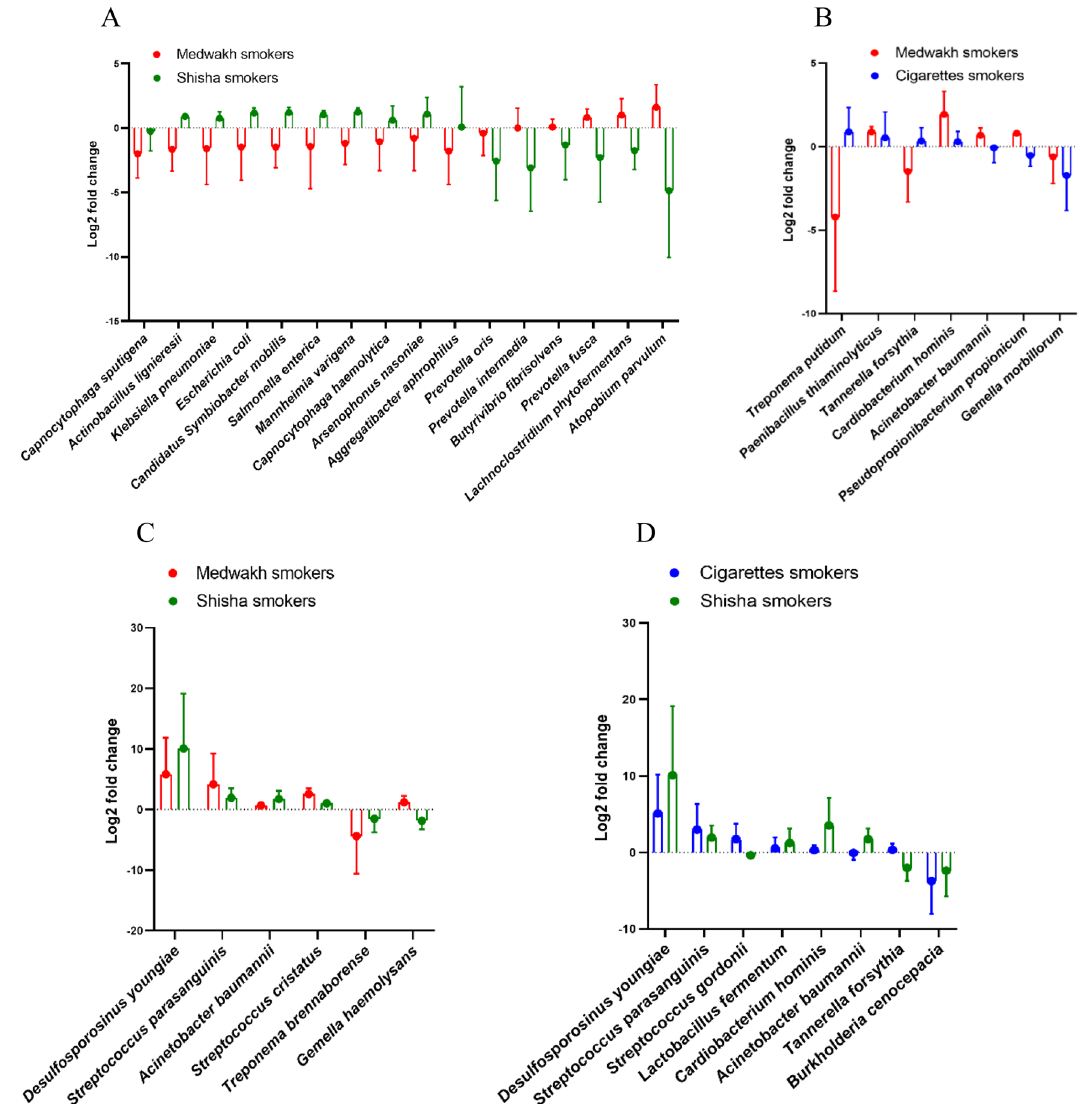
Figure 6. Comparison of the relative abundance of species detected in smokers of different tobacco types in patients with no-low caries ( A ) and patients with moderate-high caries ( B – D ). Log2 folds change of the relative abundance of each species in smokers compared to non-smokers are shown. Species with significant difference in the relative abundance were and Saccharibacteria were depleted. One major limitation of the latter study is that the status of the oral health of the participants was not considered; thus, it is difficult to conclude that microbiota alterations were caused